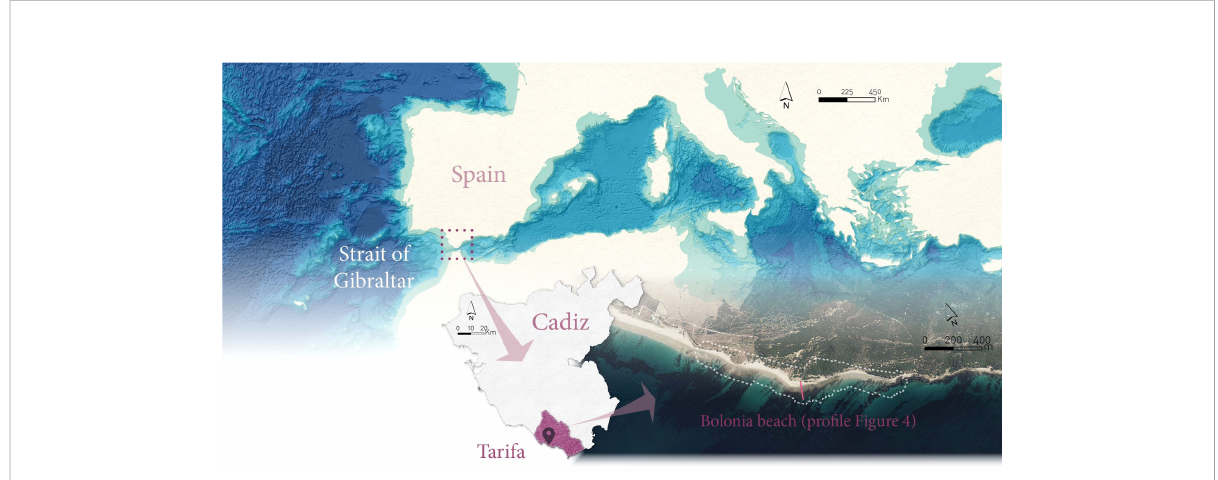
FIGURE 3 Study area on Bolonia beach (Tarifa, Spain), located on the Atlantic side of the Strait of